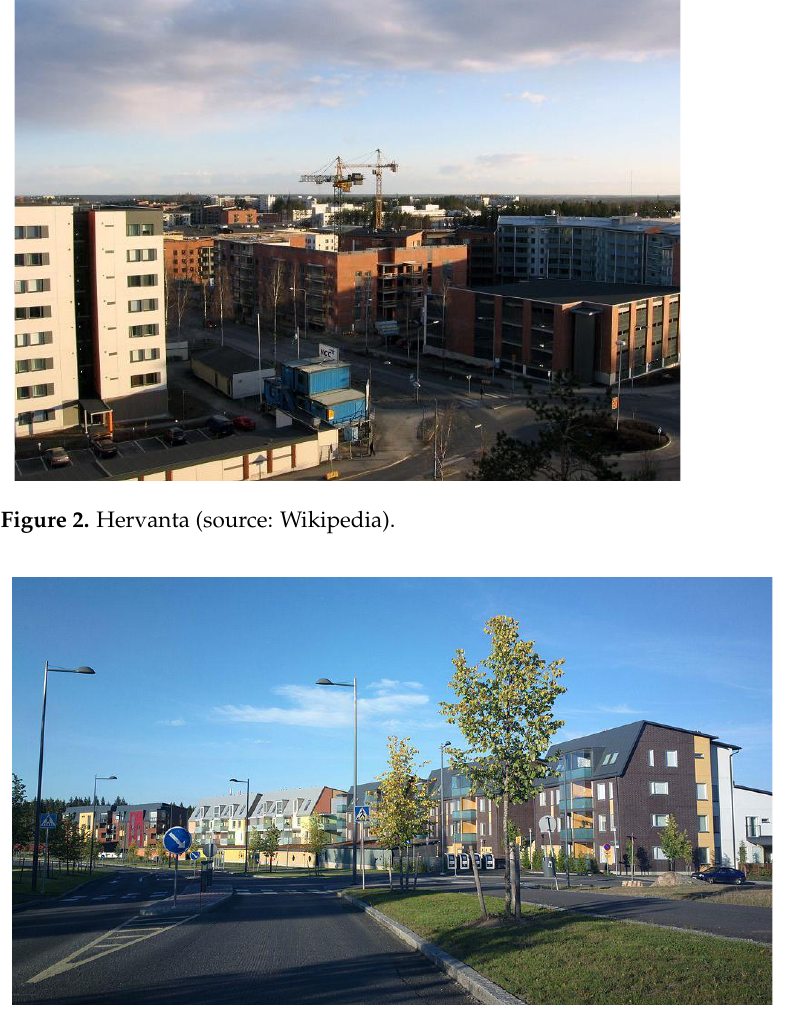
Figure 1. Hervanta, Härmälä, Kauppi, Niemenranta, and Vuores on the map.